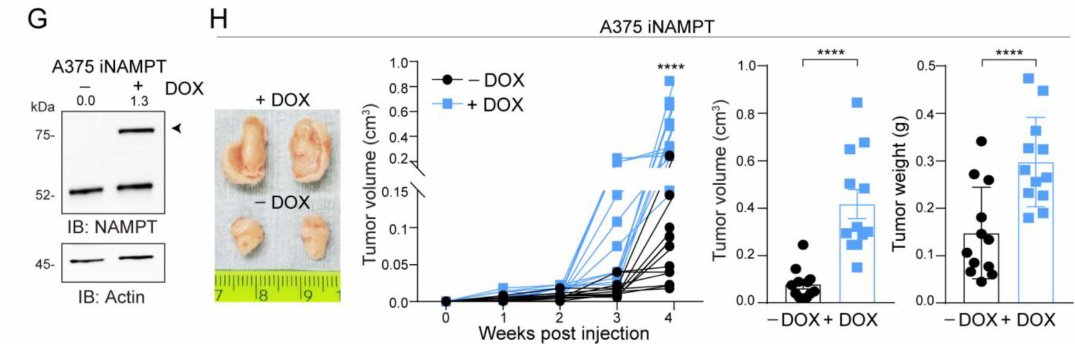
Figure 2. NAMPTover-expressionforcesMMcellsgrowthcapacityin vitroandin vivo.( A , B ) Colony-forming ability of M14 ( A ) and A375 ( B ) NAMPT / GFP in comparison with GFP control cells in untreated (UN) or treated with the indicated dose of dabrafenib (BRAFi) every 72 h for 12 days. Cells were stained with crystal violet and representative images are shown. Below the images, histograms show the cumulative quantification of the percentage (%) area with colonies at the end of the 12-days period (at least 3 independent experiments performed in triplicates, Mann–Whitney and paired t test). ( C , D ) Representative images of soft-agar colony-forming ability of M14 ( C ) and A375 ( D ) NAMPT / GFP in comparison with GFP control cells in complete medium for 20–25 days. On the right, cumulative data of the area with colonies are shown (measured from at least 3 di ff erent fields of 3 pictures of 3 independent experiments, Mann–Whitney test). ( E , G ) Western blots showing inducible NAMPT / GFP expression (the band indicated with the arrow) upon doxycycline (DOX, 1 µ g / mL, 72 h) treatment of NAMPT-inducible (i) M14 ( E ) or iA375 ( G ) cell lines. Actin was used as loading control. Densitometry intensity ratios of NAMPT / GFP bands (indicated with arrows) over actin were reported. ( F , H ) Representative tumor masses derived from NSG mice xenografted with iM14 ( F ) and iA375 ( H ) variants (5 × 10 6 cells, injected subcutaneously) and treated or not with DOX (0.1 mg / mL, twice a week orally) for 4–5 weeks. At least 8–10 animals for each condition were evaluated. Graphs represent tumor volume growth kinetics over a period of 4–5 weeks post-injection, cumulative tumor volume and tumor weight at sacrifice for both cell lines. Mann–Whitney test. Data in the Figure are presented as the mean ± SEM. Significance was represented as: * p ≤ 0.05, ** p ≤ 0.01, *** p ≤ 0.001 and **** p ≤